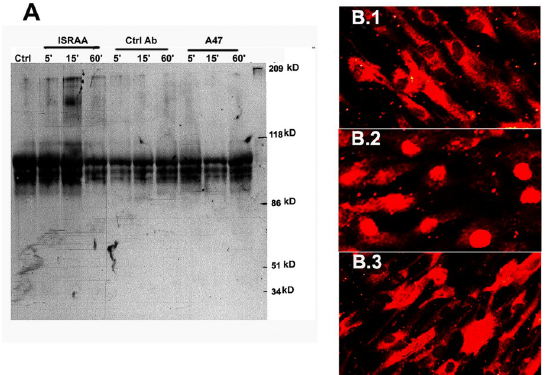
Fig 6. Illustration of the IFN- γ signaling pathway activated on embryonic brain astrocytes upon ISRAA stimulation. To demonstrate the IFN- γ signalling pathway activation on embryonic brain astrocytes after ISRAA stimulation, tyrosine kinase activity and nuclear localisation of the transcription factor STAT1 in E21 astrocytes were examined using Western blot analyses and immunohistochemistry respectively. A. Phosphorylation of tyrosine- specific protein. Cell lysates were prepared 5min, 15min and 60min after ISRAA stimulation. Note the slight amounts of tyrosine phosphorylated proteins in the non-stimulated control lysates (Ctrl) on lane 1. ISRAA stimulation resulted in a strong and fast rise in tyrosine phosphorylation, which reached its highest point by 15min and declined to the control level at 60min (ISRAA; lane 2, 3, 4). An irrelevant antibody (Ctrl Ab; lane 5, 6, 7) was used to control the specificity of the phosphorylated protein. The band representing activated TPKs (lane 3, 15 min on ISRAA) was not detected. Tyrphostin A47 (a tyrosine kinase specific inhibitor) blocked the ISRAA induced protein kinase as demonstrated by the inhibition of the at the various detection times (A47; lane 8, 9, 10). B. Nuclear localisation of the STAT1. Nuclear localisation of the STAT1 protein was detected in E21 astrocytes 5min, 15min and 60min after ISRAA stimulation. The shown pictures were obtained by a digital camera using a fluorescence microscope at x630 magnification after 15min incubation. B.1 represents non-stimulated cells (note the generalised cytoplasmic antigen distribution before ISRAA treatment; red stained cytoplasm and black non-stained nuclei). B.2 depicts the nuclear translocation of STAT1 15 min after ISRAA stimulation (heavily stained nuclei in red). B.3 demonstrates the